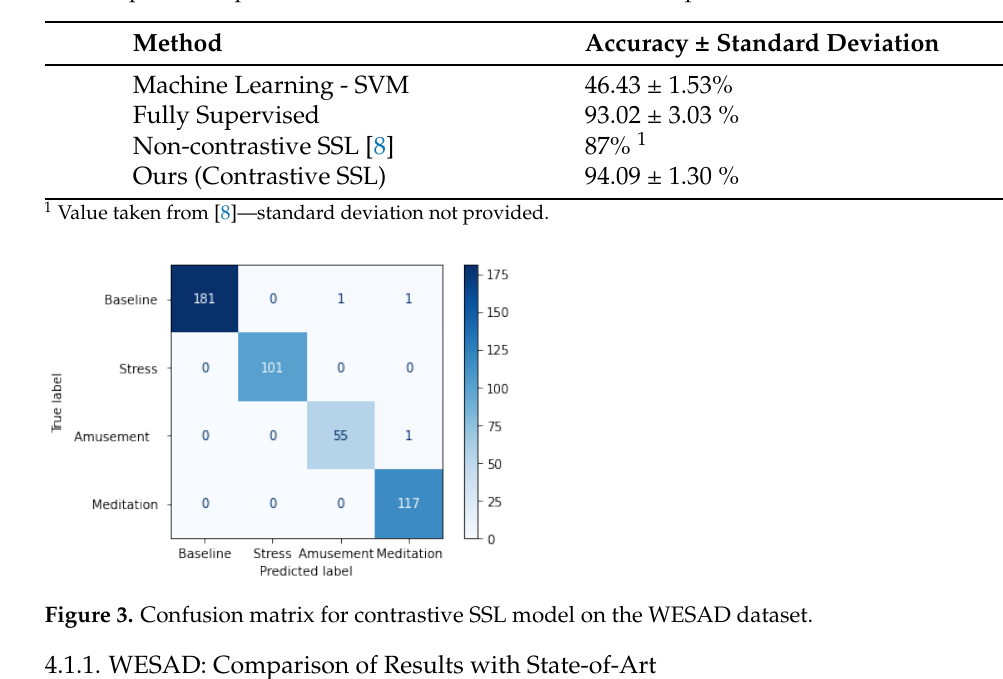
Table 1. Our results compared with supervised baseline and prior works on the WESAD dataset. All of the experiments presented in this table use a 10–90 test–train split.